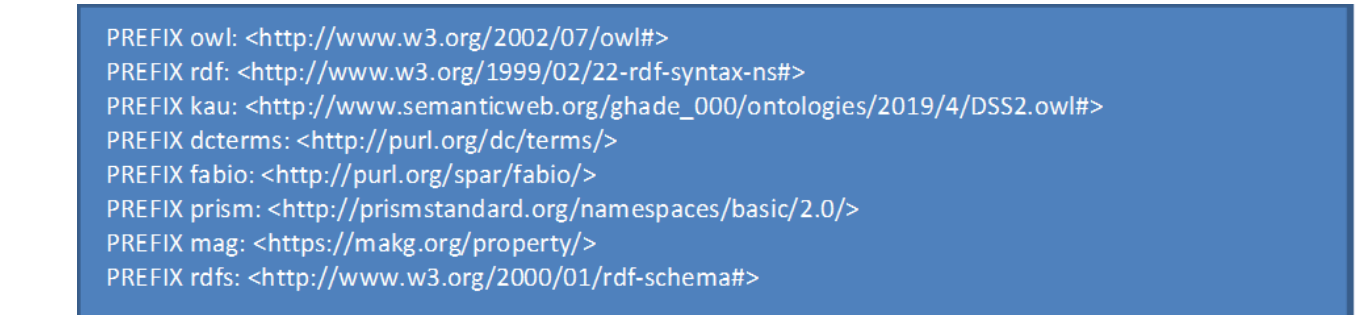
Figure 8. Prefixes used when querying the resulting data.